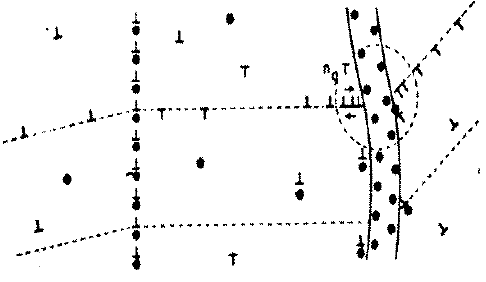
Figure 3. Polycrystal dislocation slip.